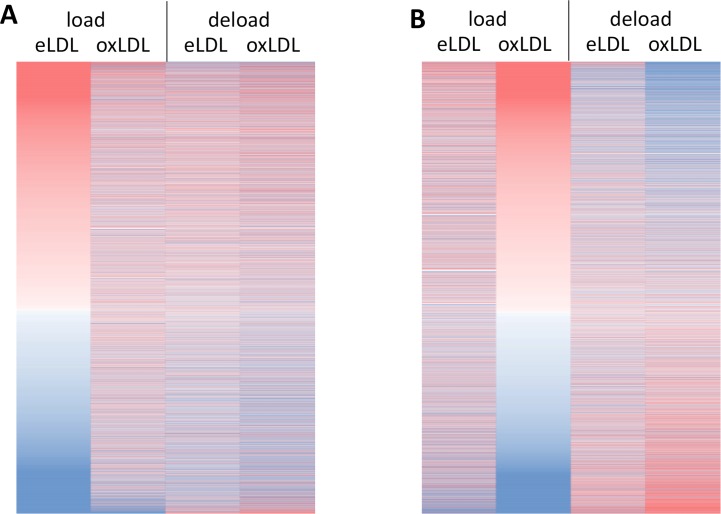
Heatmap of hypergeometrical scores for transcripts quantified in Agilent microarrays.Red signifies positive and blue negative values, indicating up- and down regulation respectively. (A) sorted by “eLDL load” hypergeometrical score, (B) sorted by “oxLDL load” hypergeometrical score. n = 9 microarray profiles from independent donors.